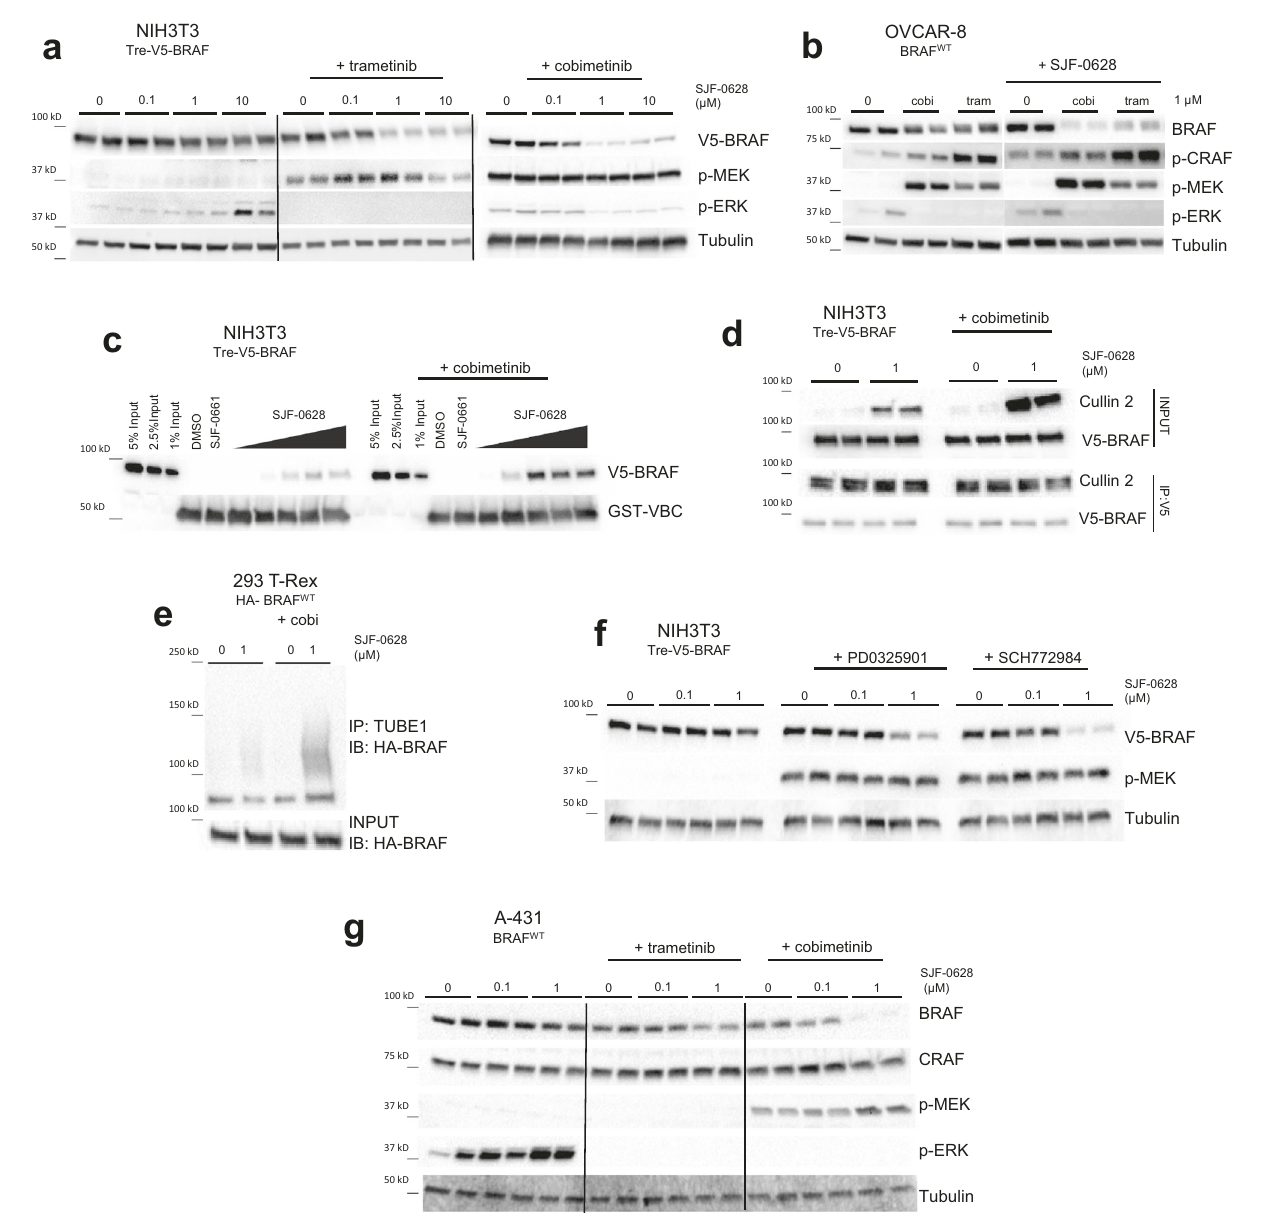
Fig. 3 BRAF-activating MEK inhibitors also sensitize BRAF to PROTAC-induced ubiquitination and degradation. a NIH3T3 cells with trametinib (1 µ M, 5 h) or cobimetinib (500 nM, 3 h) pre-treatment subsequently treated with increasing amounts of SJF-0628 (20 h) promote degradation of BRAF WT and show a marked increase in p-MEK ( n = 2 biologically independent samples). b OVCAR8 cells pre-treated with cobimetinib and trametinib (1 µ M, 2 h) promote MEK and CRAF phosphorylation as well as BRAF degradation in the presence of SJF-0628 ( n = 2 biologically independent samples). c Cell lysate- based ternary complex assay shown in 2c but using NIH3T3 lysates expressing BRAF WT and pre-treated with DMSO or 1 µ M cobimetinib for 3 h. Cobimetinib pre-treatment promotes ternary complex formation. d V5-BRAF immunoprecipitation in NIH3T3 cells pre-treated with 1 µ M of cobimetinib (2 h) followed by treatment of SJF-0628 for 2.5 h. e TUBE1 pulldown in 293 T-Rex cells stably expressing HA- BRAF WT treated with cobimetinib (cobi) (2 h, 1 µ M) and subsequently treated with SJF-0628 (2 h). f NIH3T3 cells pre-treated with 1 µ M PD0325901 (MEK inhibitor) or SCH772984 (ERK inhibitor) for 3 h followed by treatment with indicated amount of SJF-0628 for 20 h. g A431 cells pre-treated with GDC-0623 and cobimetinib (500 nM for 3 h) then treated with SJF-0628 for 20 h. Source data are provided as a Source Data fi le. therapies. A 5-day treatment in SK-MEL-246 cells (Class 2, inhibition while vemurafenib showed less than 50% (Fig. 4d). BRAF G469A ) SJF-0628 ef fi caciously inhibited cell growth with and Despite causing >70% inhibition of p-ERK (Supplementary Fig. 3d), EC 50 of 45 ± 1.11 nM and the epimer showed and an EC 50 278 ± SJF-0628 showed minimal inhibition of cell growth in CAL-12-T 1.07 nM. However, vemurafenib caused some inhibition of SK- cells (Class 3, BRAF G466V ) (Fig. 4e). SJF-0628 causes potent degradation of all BRAF mutant classes MEL-246 cellular growth at concentrations above 1 μ M which and has minor effects on WT RAF. This result suggests that the was not sustained at 10 μ M (Fig. 4c). In H1666 cells (Class 3, PROTAC will be effective in treating tumors driven by these BRAF G466V ), SJF-0628 was able to induce 65% cell growth NATURE COMMUNICATIONS| (2021) 12:920